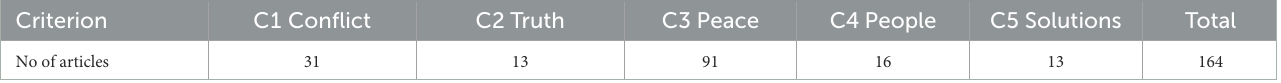
TABLE 2 Results